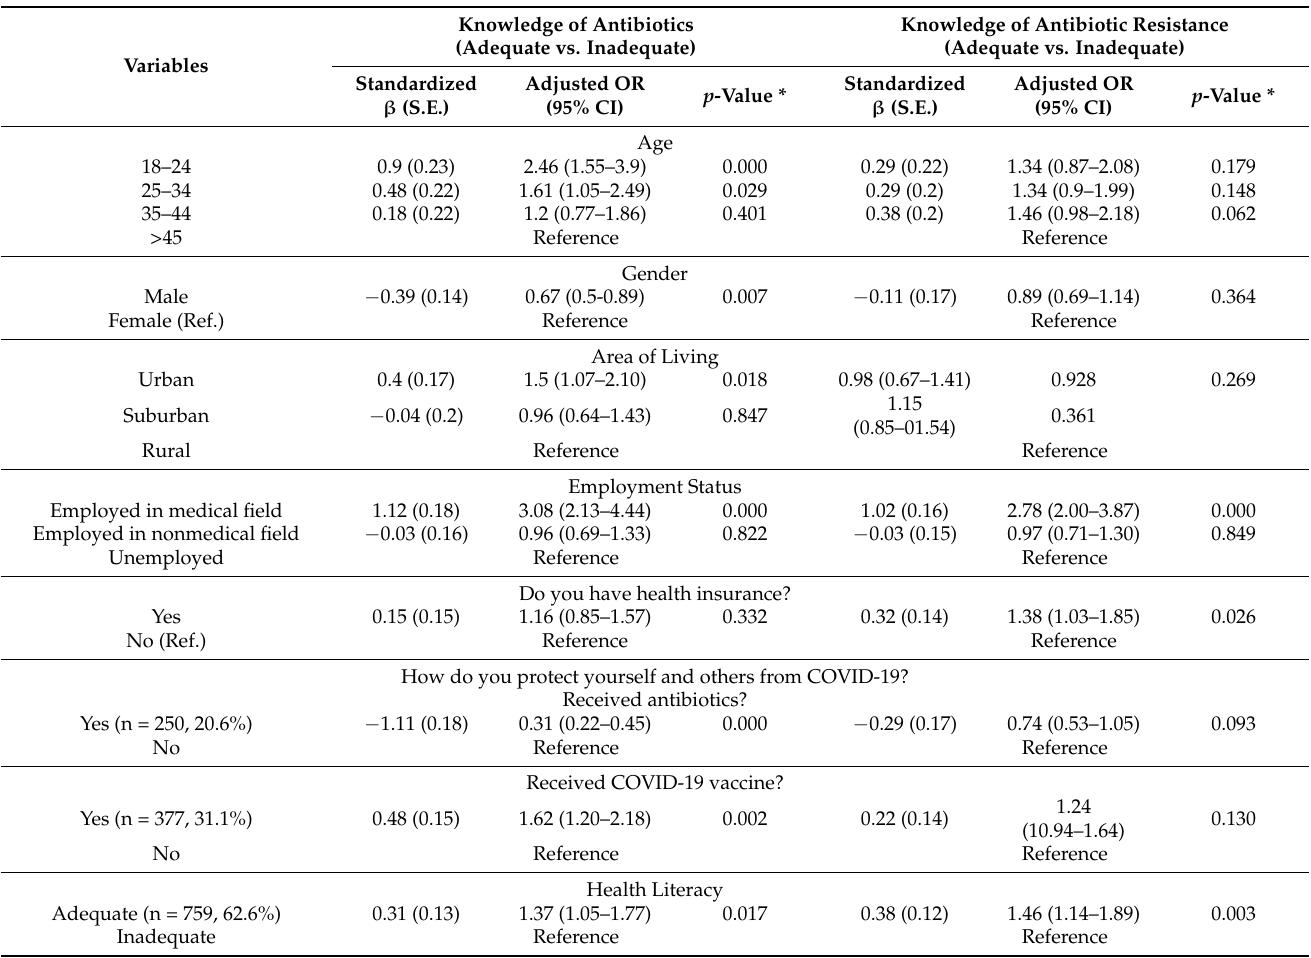
Table 5. Multiple logistic regression of sociodemographic factors and levels of health literacy associated with participants’ knowledge of antibiotics and antibiotic